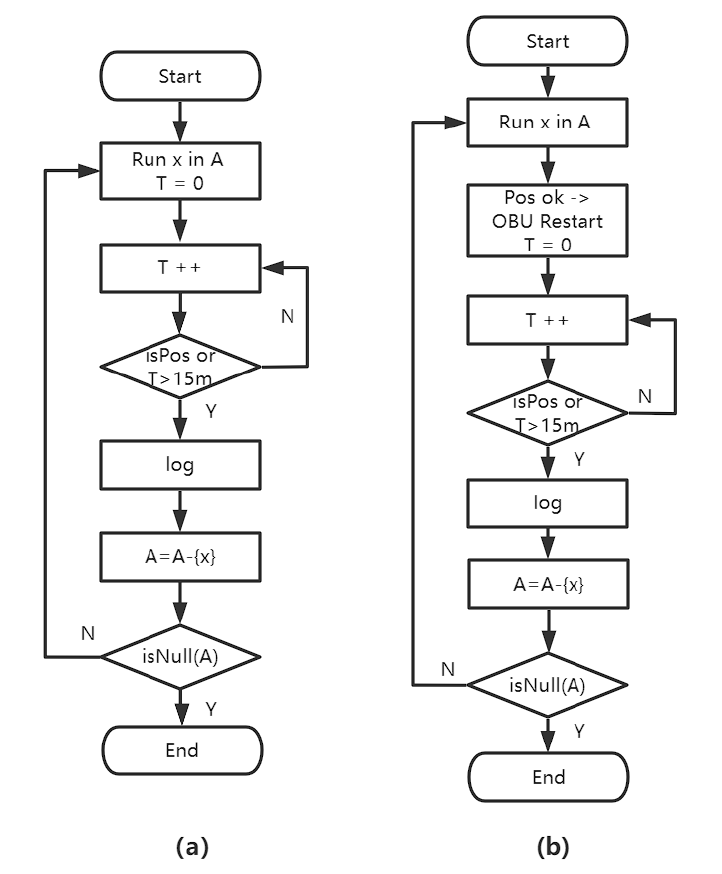
Figure 26. GNSS test: ( a ) Cold start test, ( b ) Hot start test. The hardware device is shown in Figure 27.